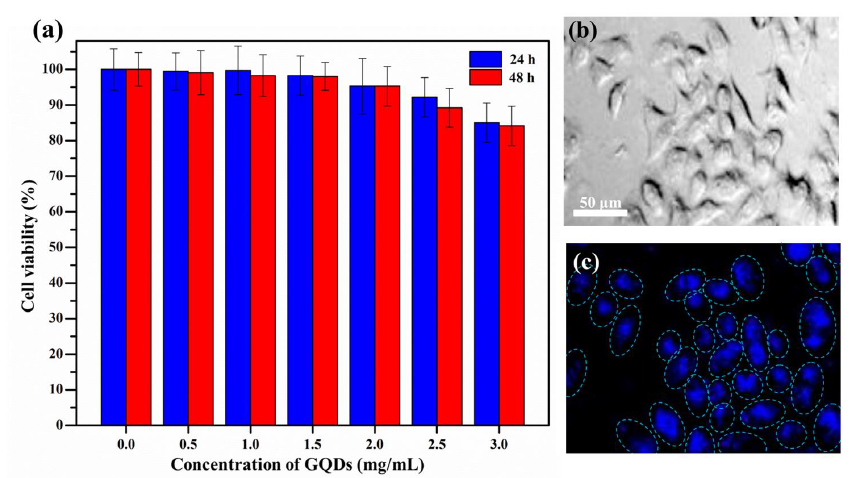
Figure 6. ( a ) Cellular cytotoxicity of (GQDs) towards HeLa cells using an MTT assay and micrographs of HeLa cells under ( b ) bright-field and ( c ) 405 nm of excitation wavelength